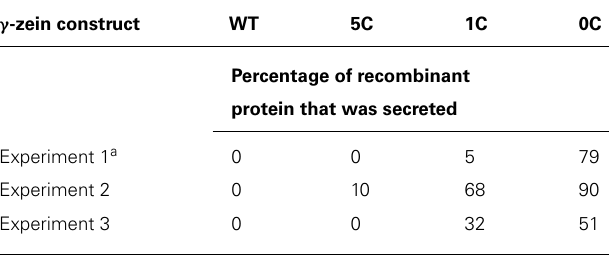
Table 1 | Secretion levels of γ -zein